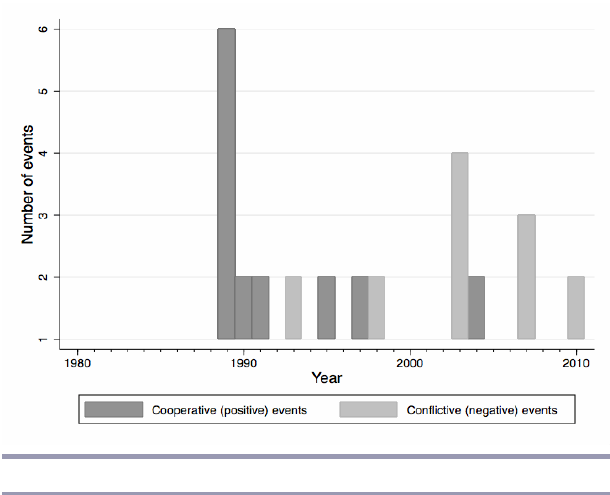
Fig. 3. Average intensity of transboundary interactions over water resources in the Salween River basin over